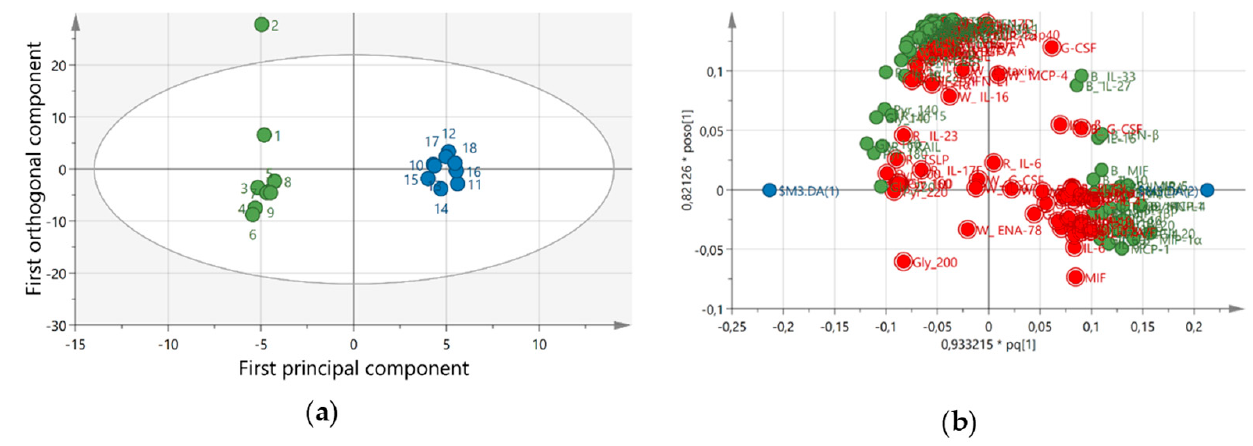
Figure 8. Score plot of the orthogonal partial least square discriminant analysis (OPLS-DA) model ( a ) and loading plot ( b ) for all data. The score plot shows a clear separation between samples dynamic computer working (DCW) (green circle) and after 4-weeks DCW (blue circle). The loading plot represents the substances that contribute to the separation between the groups. The important variables with variable of importance (VIP) > 1 are marked green. Red marked variables have a VIP < 1 and is regarded as non-significant analytes.